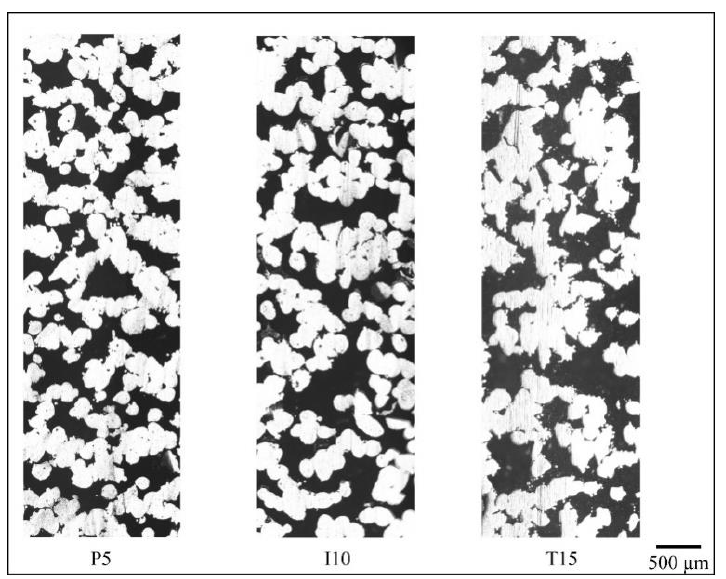
Figure 9. Flow paths in P5, I10, and T15 (lateral direction corresponds to z or printing direction in SLM.). According to Table 7, Ti-6Al-4V ELI porous material has the largest median pore size (d 50 ) [32] and specific surface area (S) indicating that the pathways for gas are more tortuous and powders are partially sintered on the pathways. Even though Ti-6Al-4V samples have larger pore paths, the more complicated zigzagging paths can reduce their permeability when compared with Inconel 718 samples. Table 7. Median pore size (d 50 ) and specific surface area (S) in SLM cellular samples.